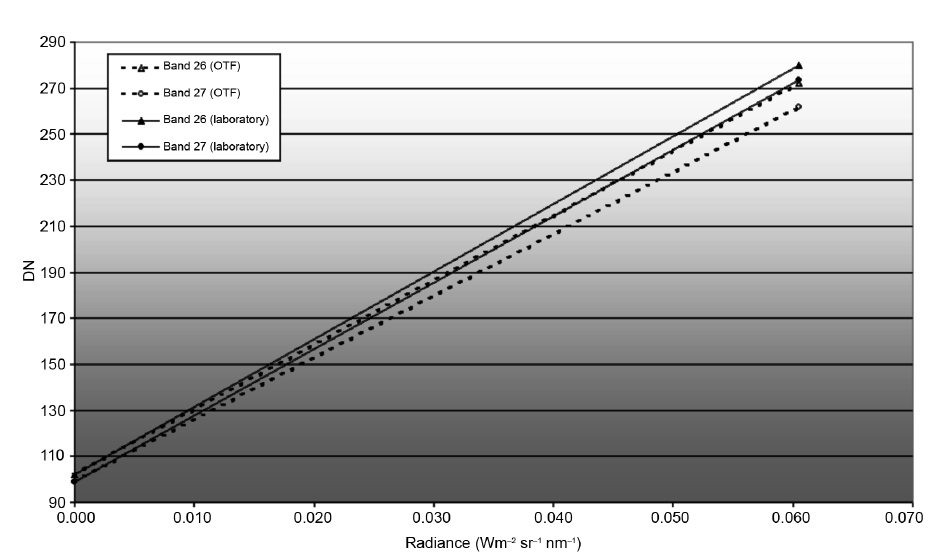
Fig. 2. Relationship between DN and at-sensor-radiance computed with the OTF procedure (OTF) and with the traditional laboratory ATP (laboratory). Comparison of results for the MIVIS spectral bands no. 26 and no. 27 using the MFTB